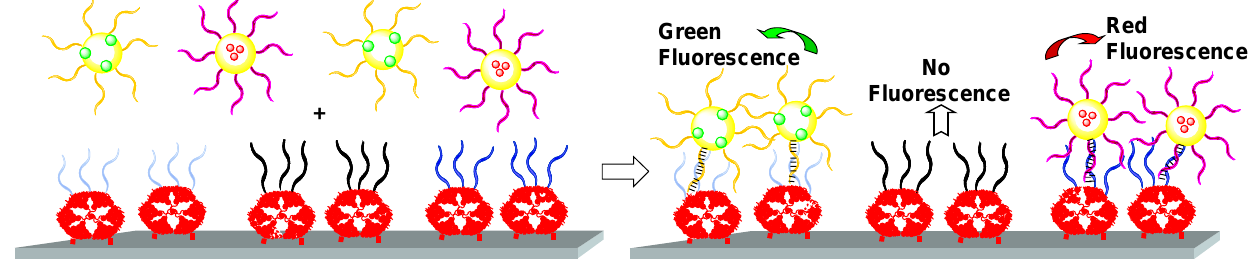
dendrimer via 4